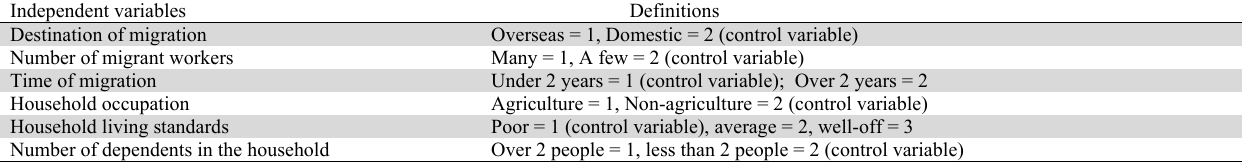
Description of independent variables in the analysis Independent variables